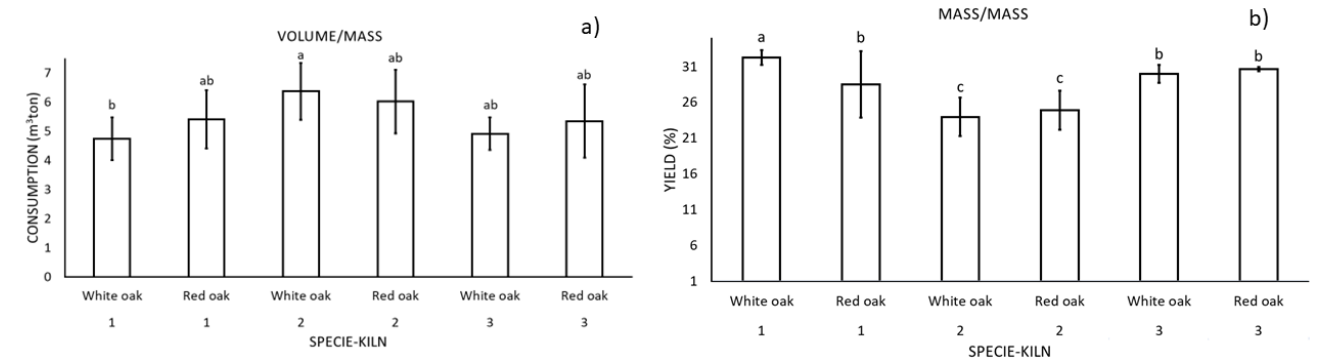
Figure 11. ( a ) Firewood consumption and ( b ) charcoal production yield in Argentine half-orange kilns. Values with the same letter are statistically equal, according to Tukey test ( p ≥ 0.05).